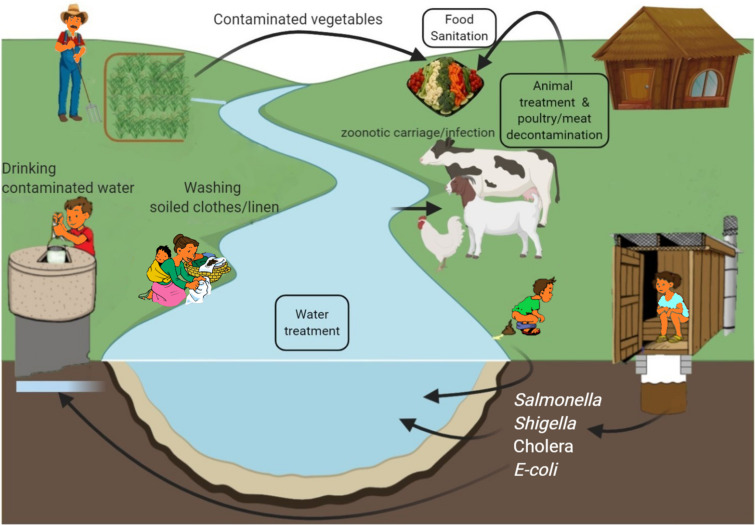
Environmental sources of common bacterial infections in developing countries and possible phage interventions (boxed text) as preventive measure.